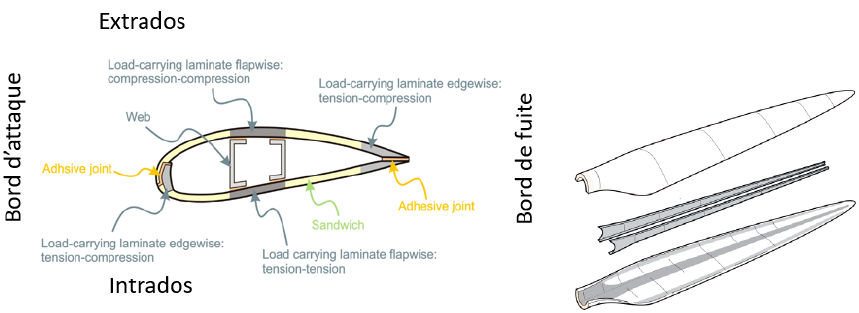
Figure 2. Design diagram of a wind turbine blade adapted [16].